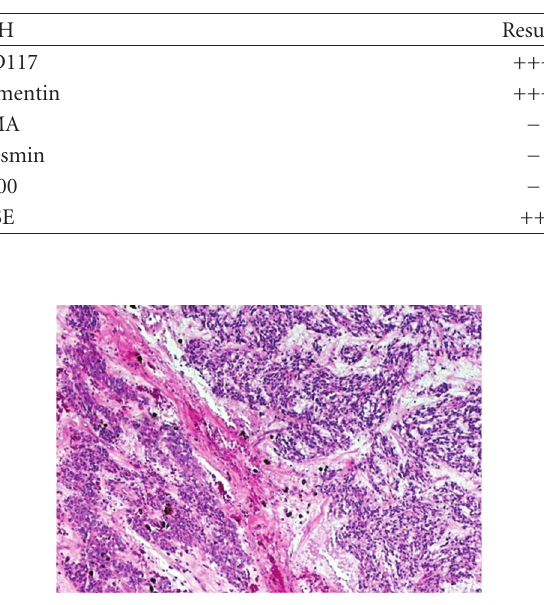
Figure 3: Predominant spindle-shaped tumor cells with a fascicular pattern. Spaces between tumor cell trabeculae are filled with ery- throcytes, siderophages and collagenous (skeinoid fibers) as well as mucinous matrix (HE).